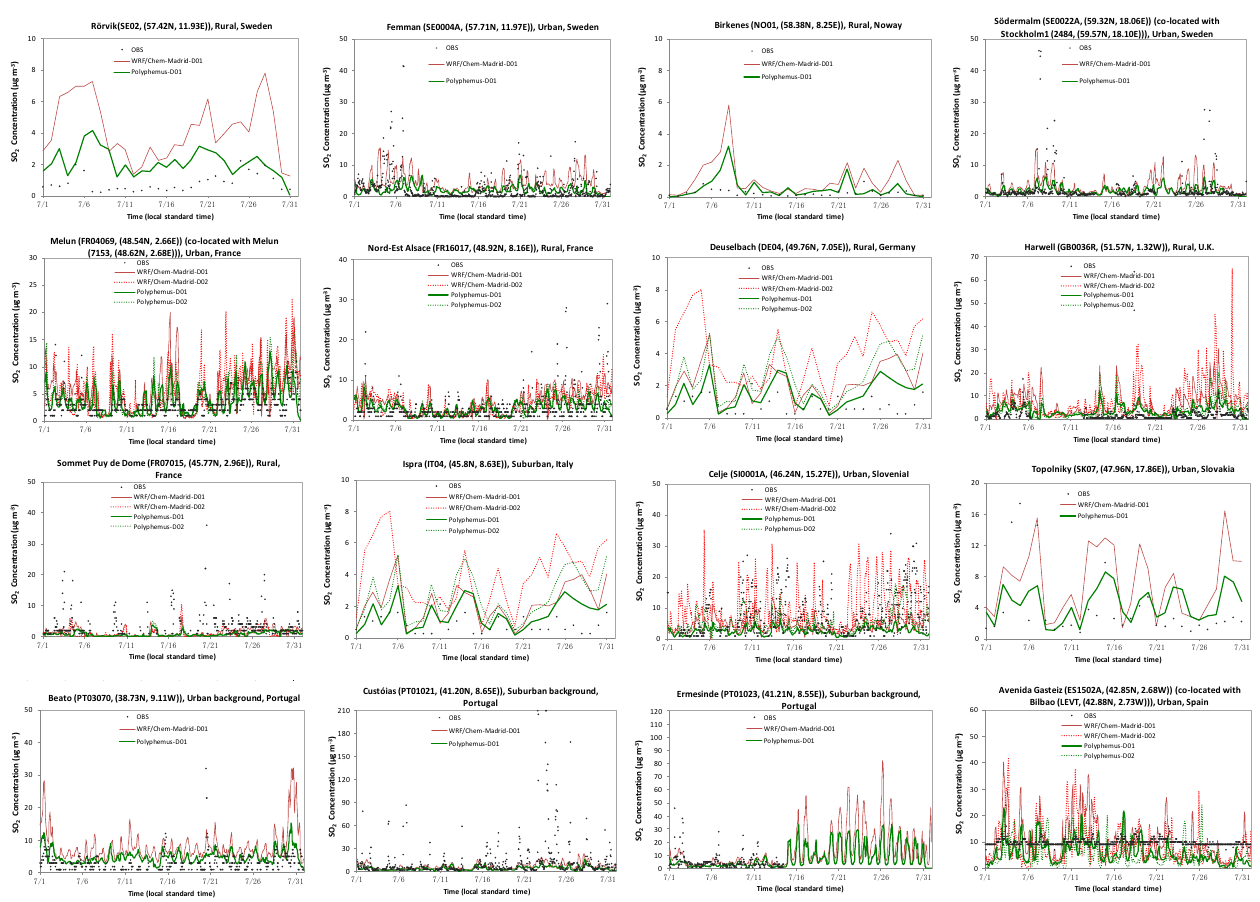
Figure 3. Simulated and observed hourly or daily concentrations of SO 2 in July 2001 at selected sites over D01 and D02 in four latitude bands: 57-60 ºN, 48-52 ºN, 45-48 ºN, and 38-43 ºN (rows 1, 2, 3, and 4, respectively).